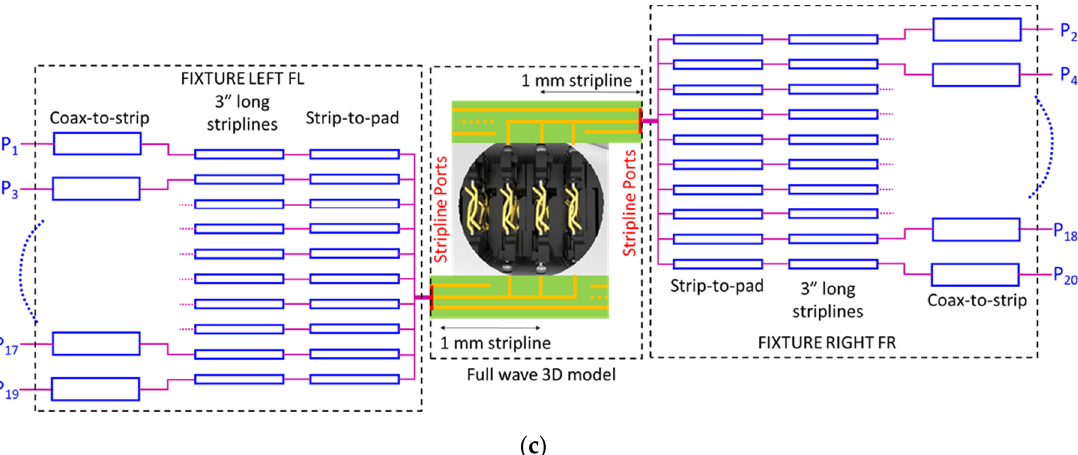
Figure 3. ( a ) Overview of the full de-embedding setup, ( b ) details of the FL and FR fixtures, ( c ) complete fixtures from the original multiport model.